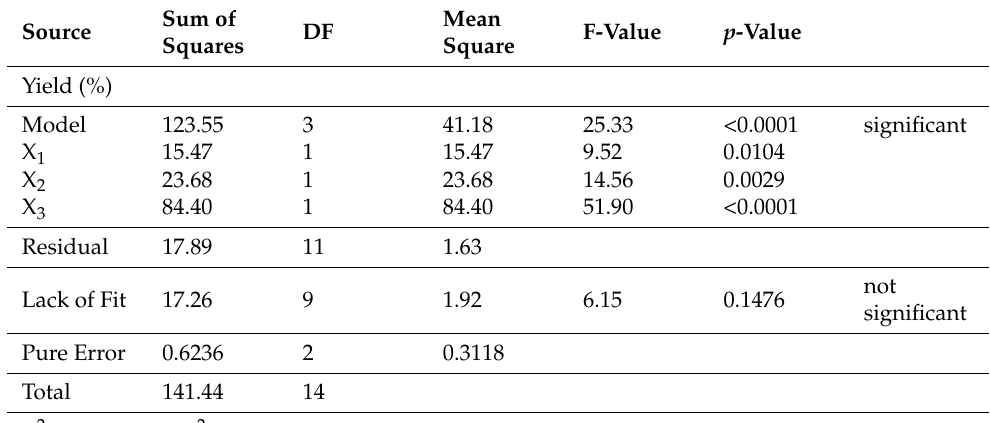
Table 5. ANOVA results for extraction efficiency and total anthocyanin content.